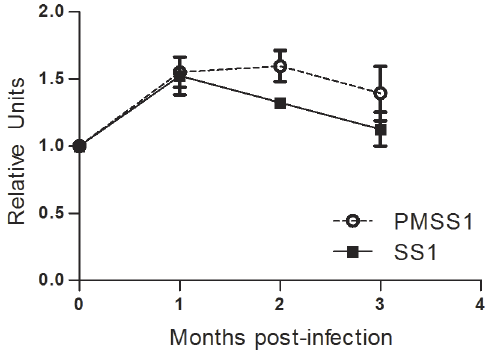
Figure 1. Expression of IL-17RB ligand, IL-17E (IL-25) following H.pylori infection in mice. Wild-type C57BL/6 mice were infected with H. pylori strain PM-SS1 or SS1 and expression of IL-17E was measured in the gastric tissue by real time rtPCR over 3 months. Relative units also known as normalized expression are a measure of the relative expression calibrated to expression in uninfected wild-type mice using GAPDH as the endogenous control. Each time point represents 5 mice per